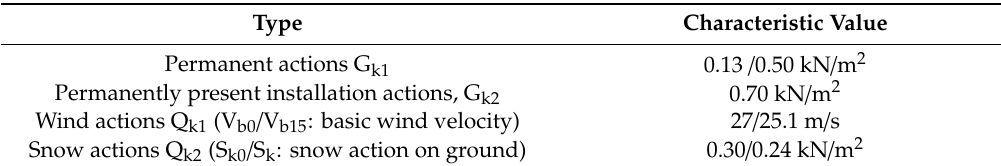
Table 3. Design actions for the assessment of the two greenhouses.